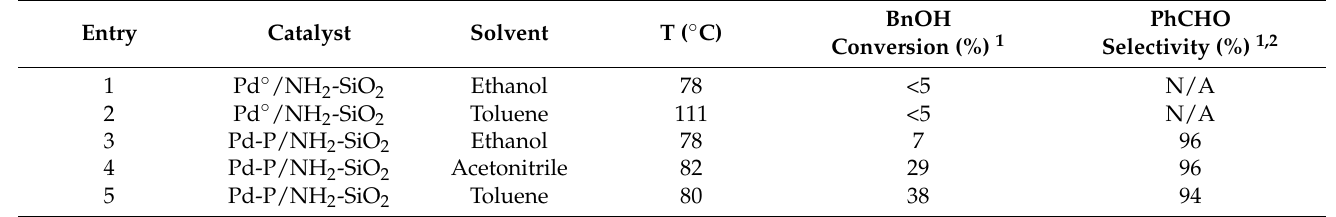
Table 5. Oxidation of benzyl alcohol (BnOH) to benzaldehyde (PhCHO); effect of